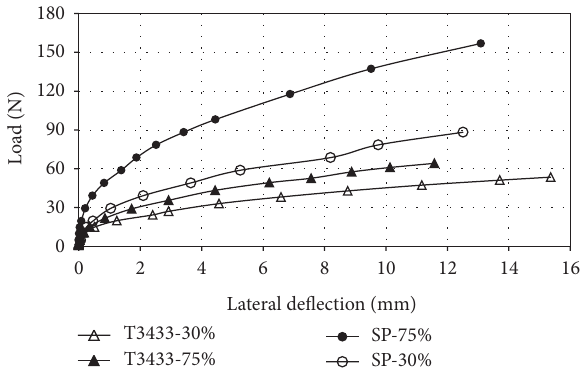
Figure 5: Lateral load versus lateral deflection (3 × 3 pile group; 𝑠/𝑑 = 6 ).